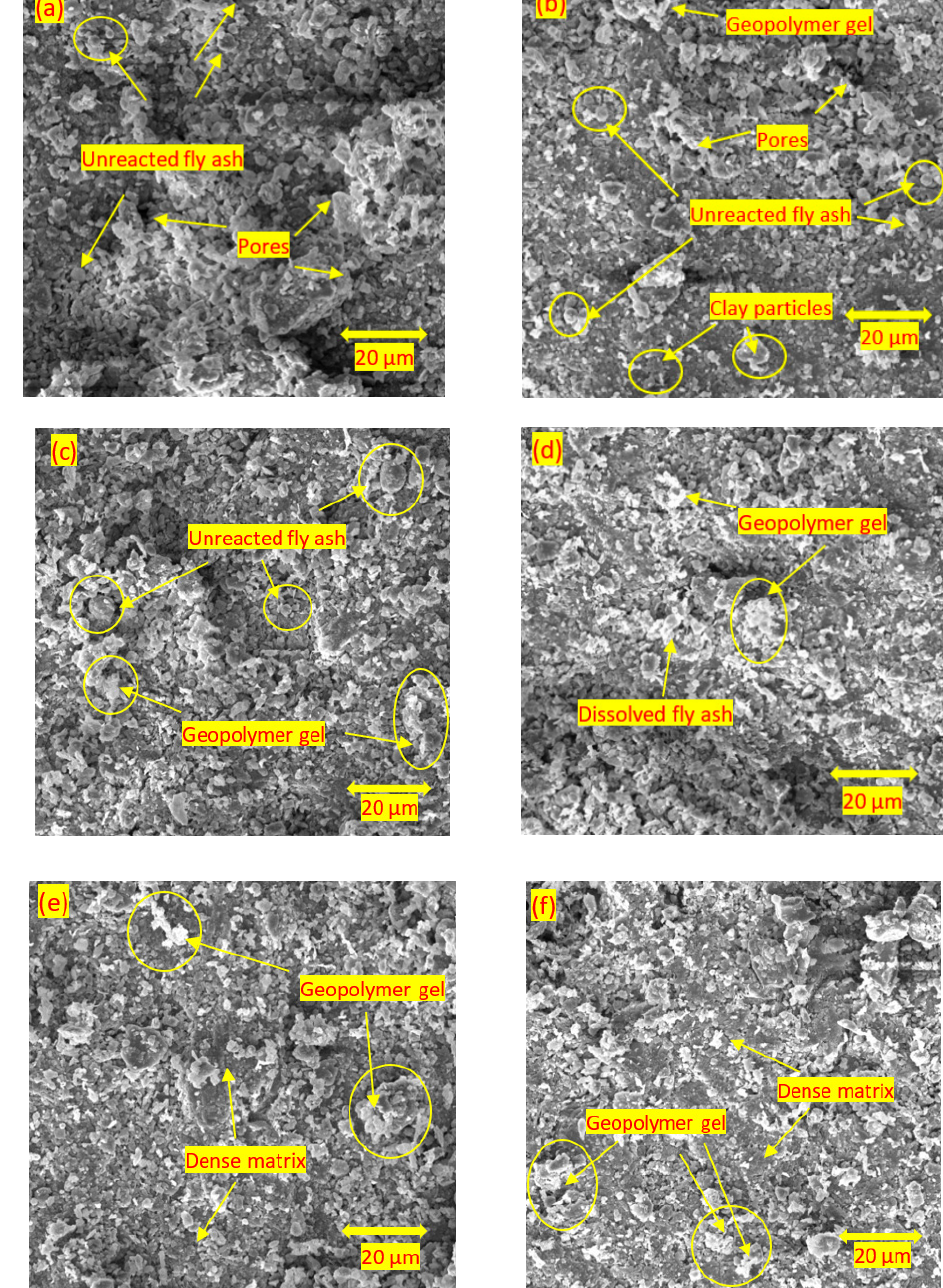
Figure 16. SEM images of soils stabilised with ( a ) 15% of alkali-activated fly ash at 1 day of curing; ( b ) 25% of alkali-activated fly ash at 1 day of curing; ( c ) 15% of alkali-activated fly ash at 7 days of curing; ( d ) 25% of alkali-activated fly ash at 7 days of curing; ( e ) 15% of alkali-activated fly ash at 28 days of curing; and ( f ) 25% of alkali-activated fly ash at 28 days of curing at 20 μ m.